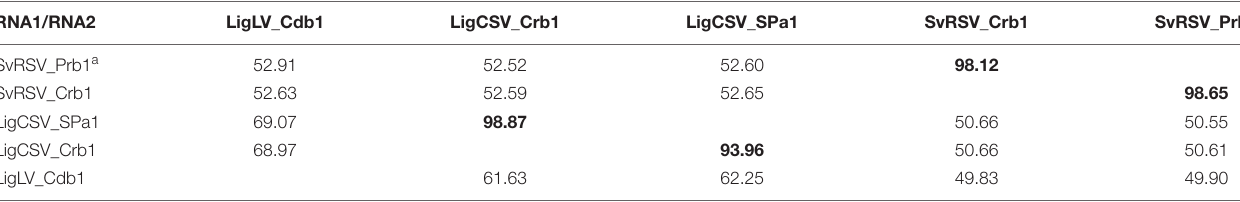
TABLE 3 | Nucleotide sequence identity amongst the RNA segments of viruses described in this study.